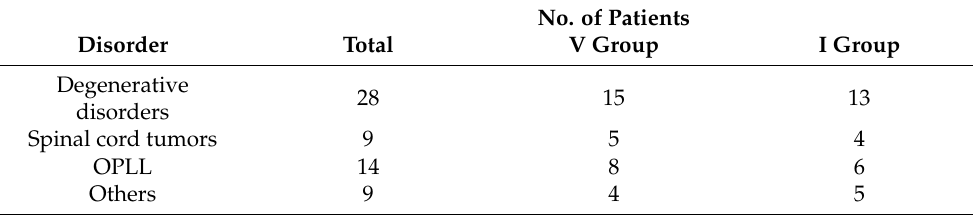
Table 2. Cervical disorders in patients ( n = 60).